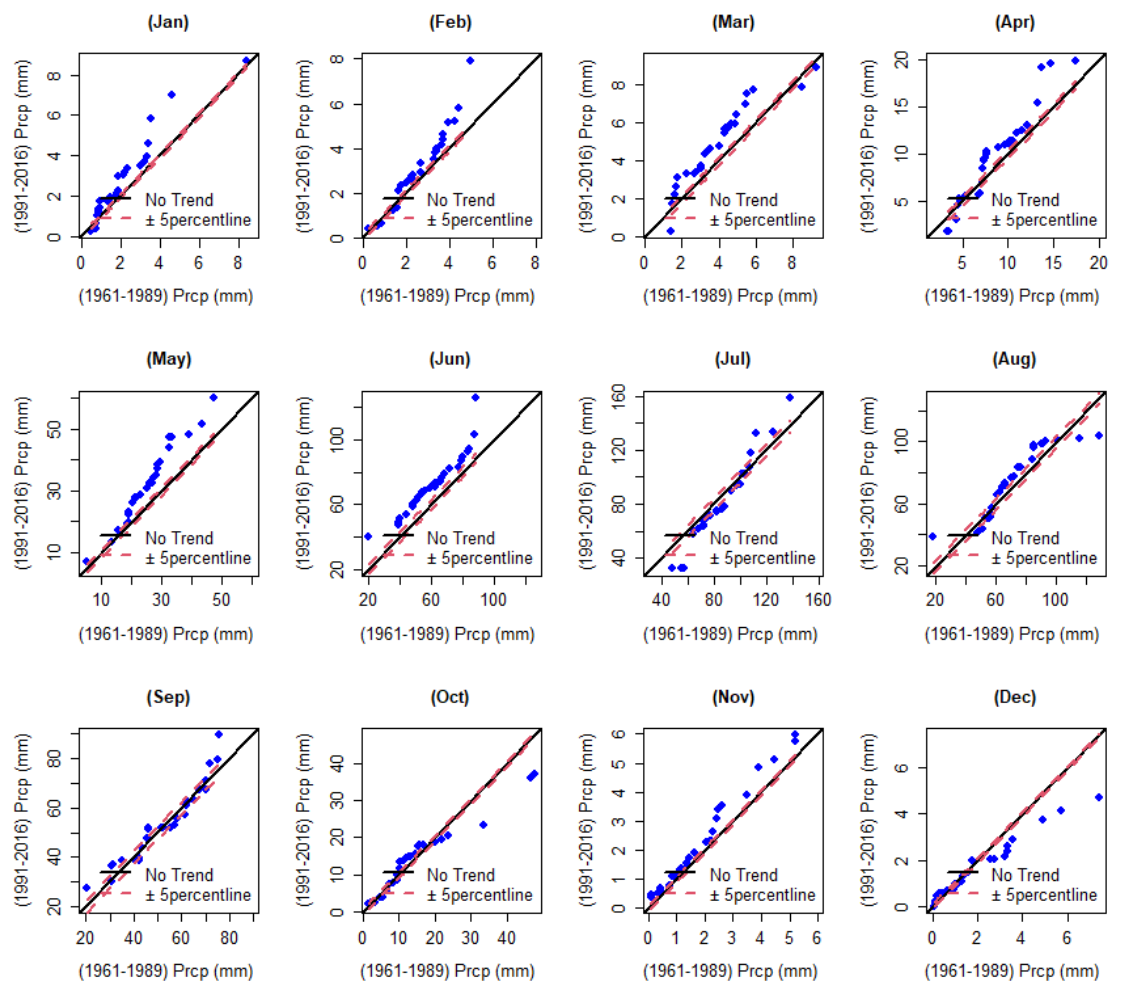
Figure 7. Monthly graphical representation of ITA results for precipitation time series (1961 – 2016).